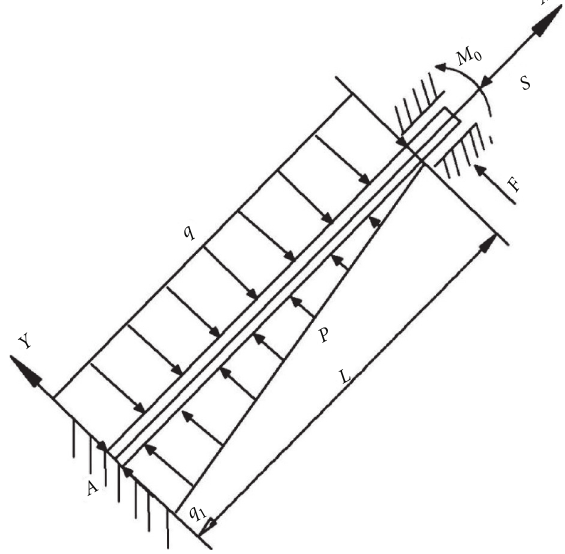
Figure 2: Mechanical model of the roof